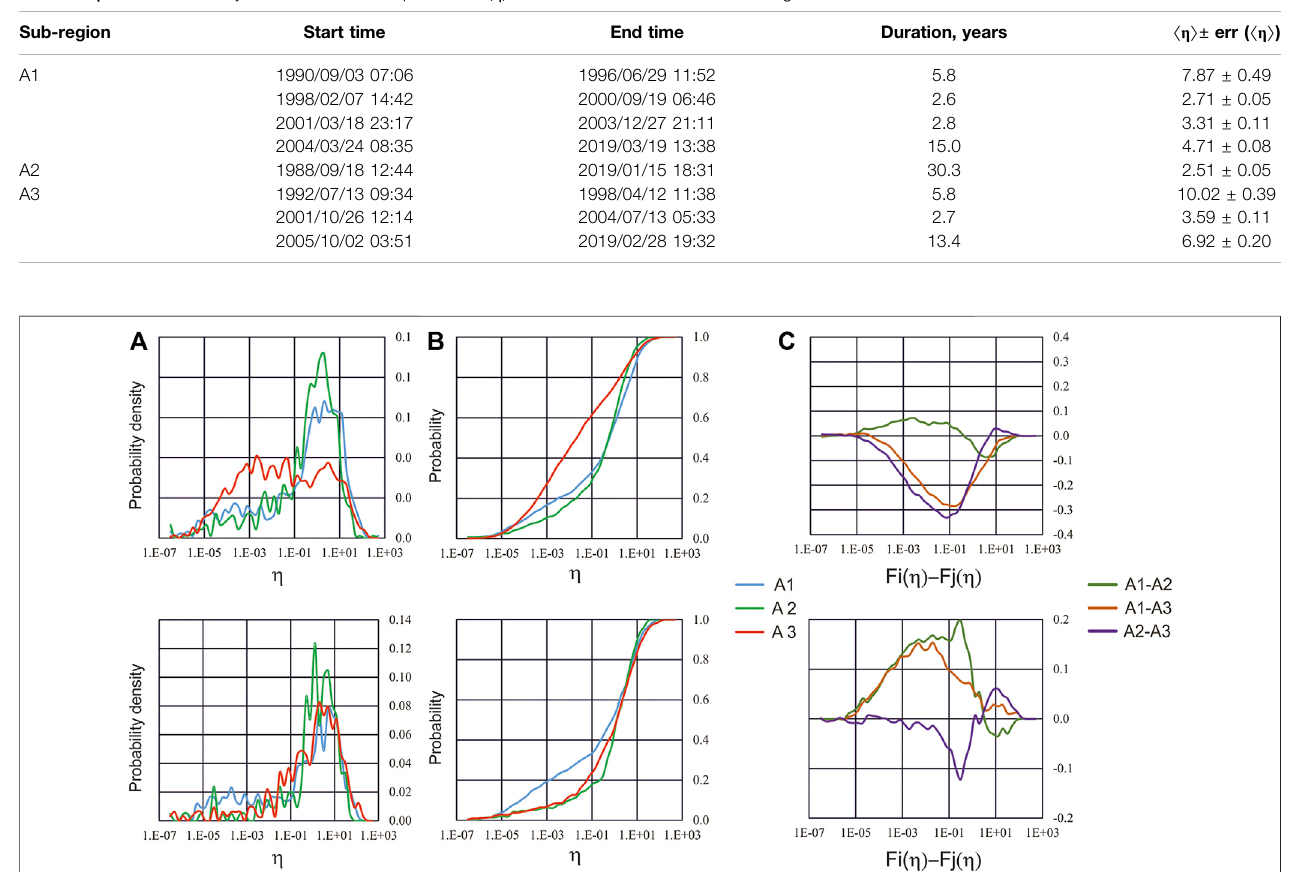
FIGURE 8 | Empirical density (A) and cumulative (B) distribution functions of USLE control parameter η and (C) pairwise difference F i ( η ) − F j ( η ) for A1, A2 and A3 FVG sub-regions in 1988 – 2019 time interval (top panels) and in 2005/10/2 – 2019 time interval (bottom panels).